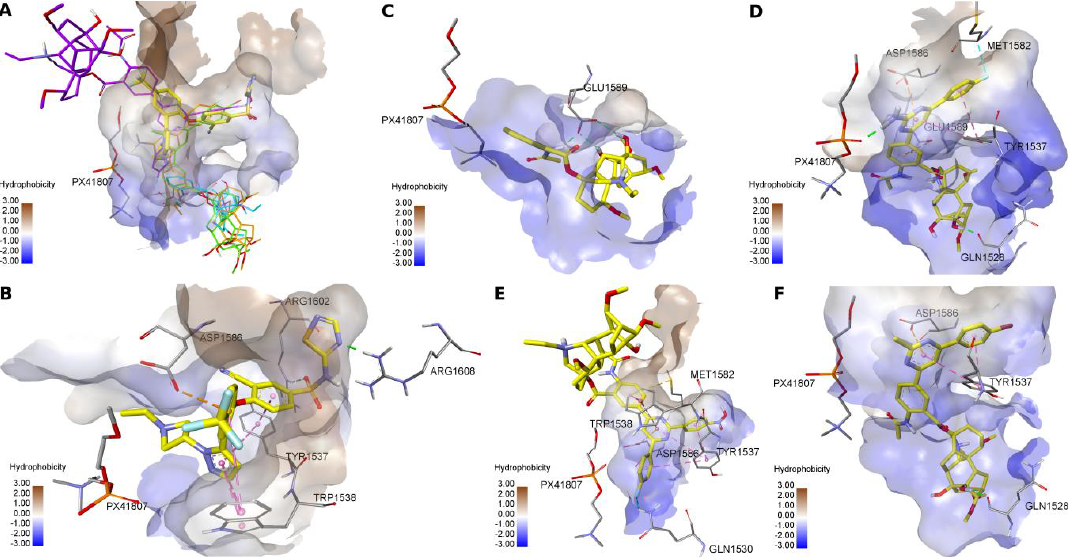
Figure 4. Features of the location and non-covalent interactions of the new lappaconitine derivatives at the sodium channel 1.7 binding site versus the GX-936 antagonist. ( A ) Superposition of structures in the binding site (structures are highlighted in color: yellow—GX-936, blue— 1 , orange— 10 , purple— 12 , green— 15 ), ( B ) GX-936, ( C )–lappaconitine 1 , ( D )— 10 , ( E )— 12 , ( F )— 15 . Non-covalent interactions of compounds in the active site are shown by dotted lines: green—hydrogen bonds, orange—electrostatic interactions, violet—stacking interactions, blue—halogen bonds. PX-41807 is a cell membrane phospholipid.